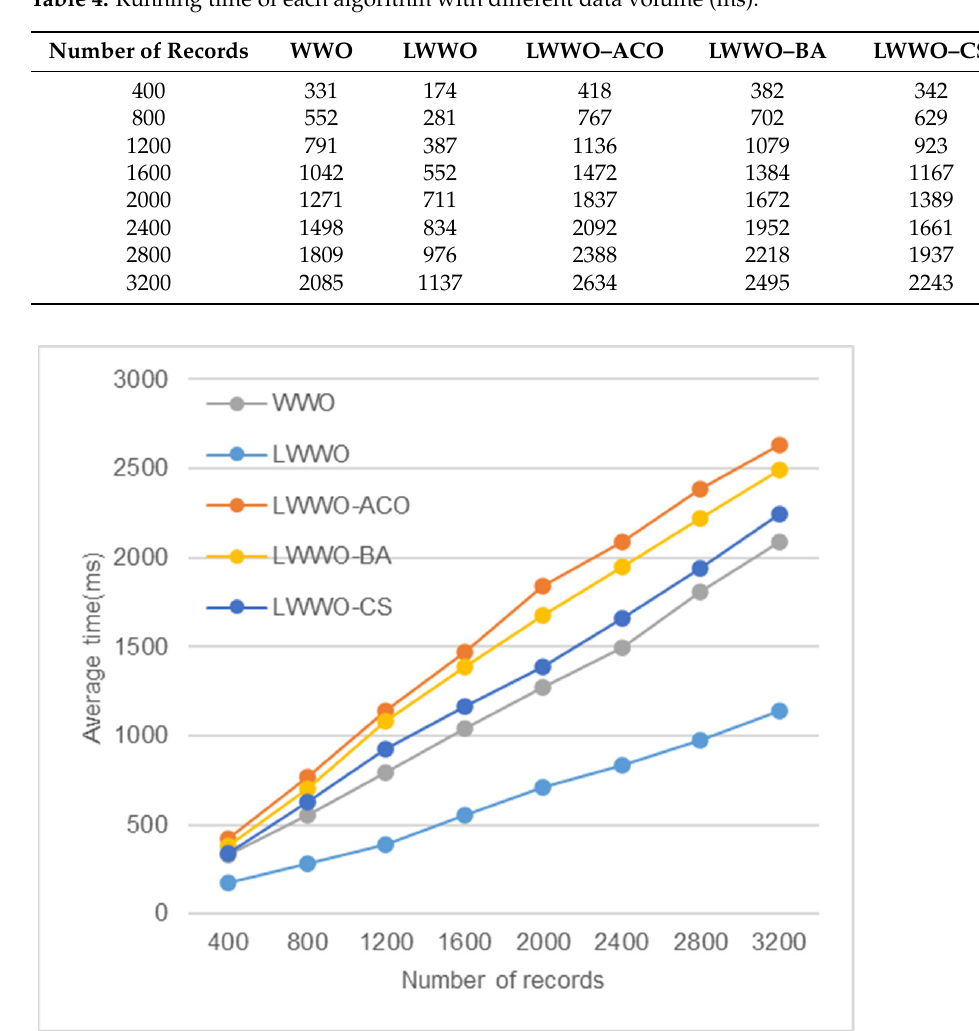
Table 4. Running time of each algorithm with different data volume (ms).